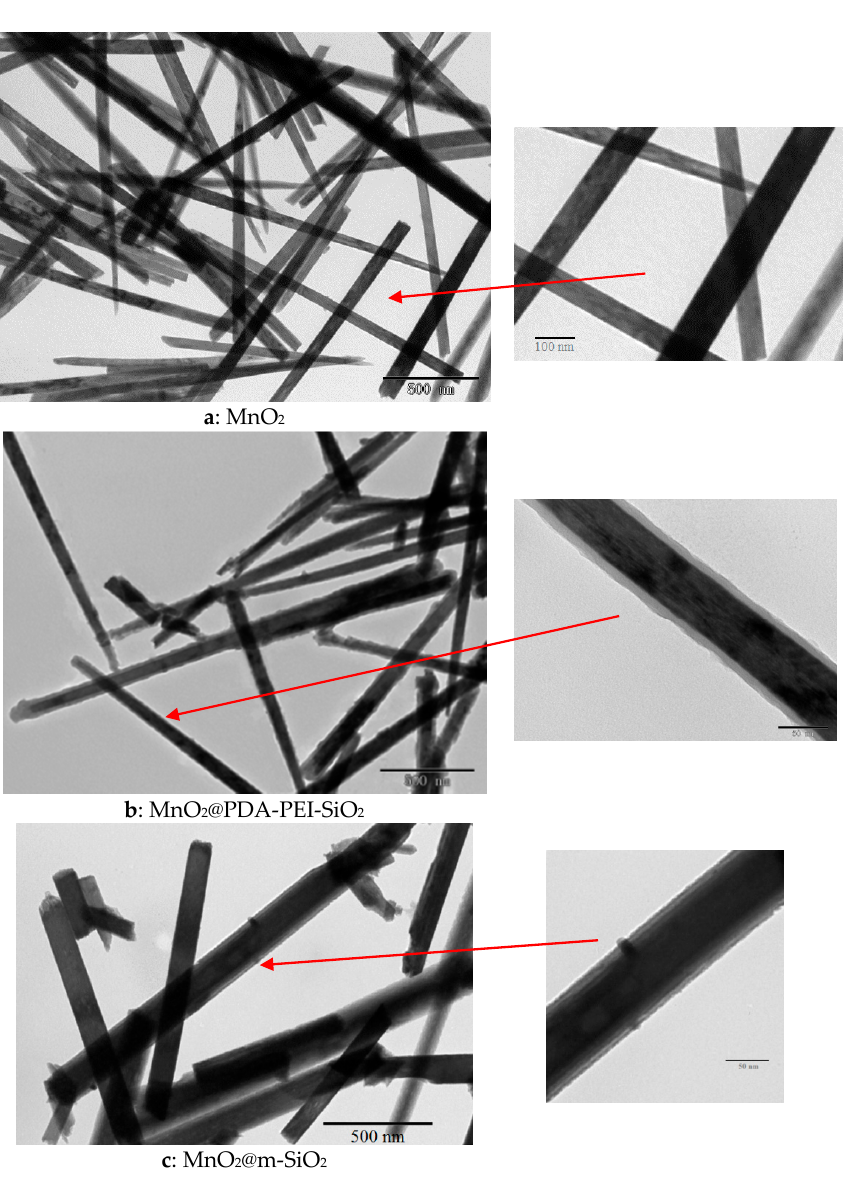
Figure 6. TEM images for MnO 2 , MnO 2 @PDA ‐ PEI ‐ SiO 2 , and MnO 2 @m ‐ SiO 2 . ( a ) MnO2 nanorods; ( b ) By sequentially coating PDA and PEI and further silicification, a dense film was clearly observed on MnO 2 @PDA ‐ PEI ‐ SiO 2 ; ( b ) The film of PDA ‐ PEI ‐ SiO 2 became mesoporous SiO 2 by removing the PDA ‐ PEI coatings through calcination under 400°C. A tiny gap between the MnO 2 core and the mesoporous SiO 2 shell was generated ( c ).